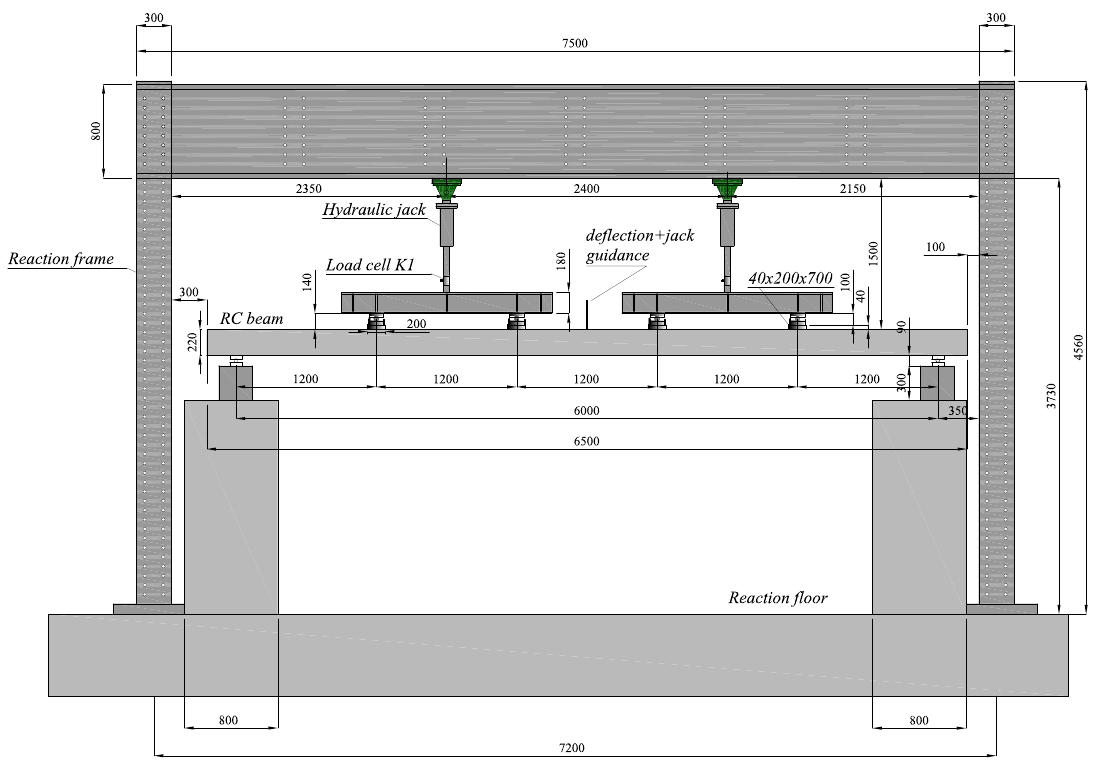
, and ultimate, R , tensile strength of the inner longitudinal steel p, 0 . 2 m